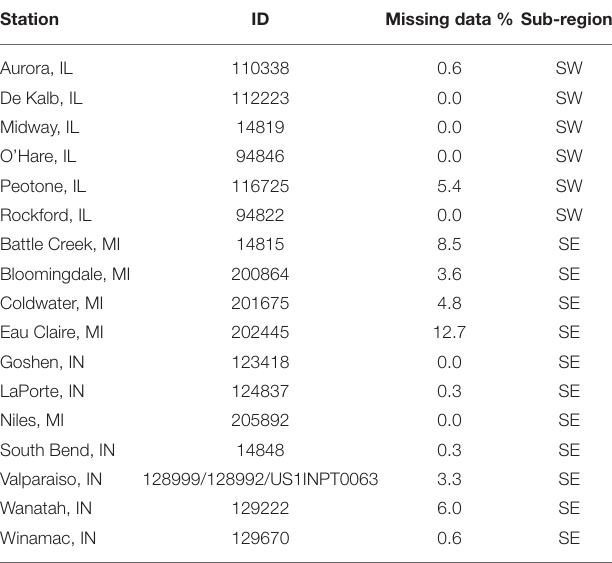
TABLE 1 | Information on snowfall locations, including the identification number, missing data indicator, and sub-region from Clark et al. (2016). Station ID Missing data % Sub-region Aurora,